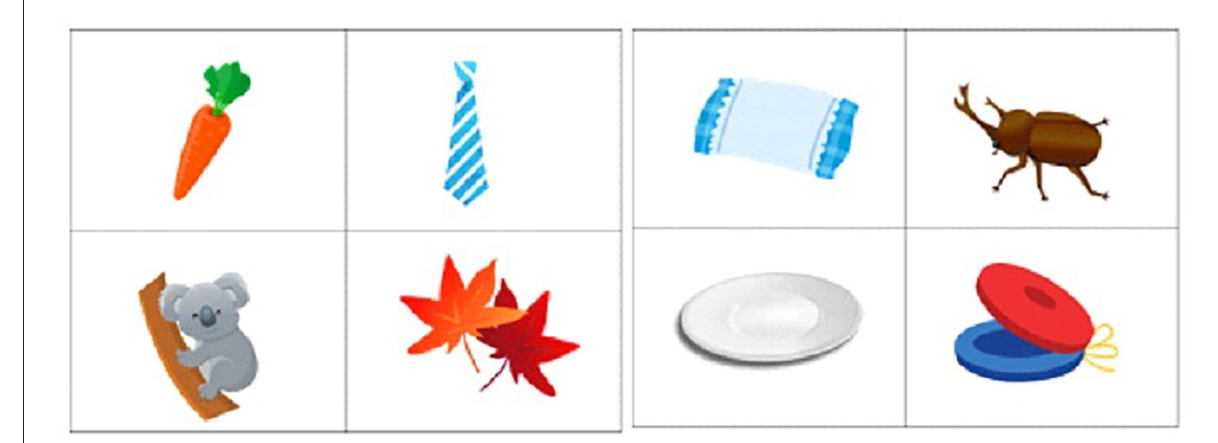
FIGURE1 The illustrations on 8